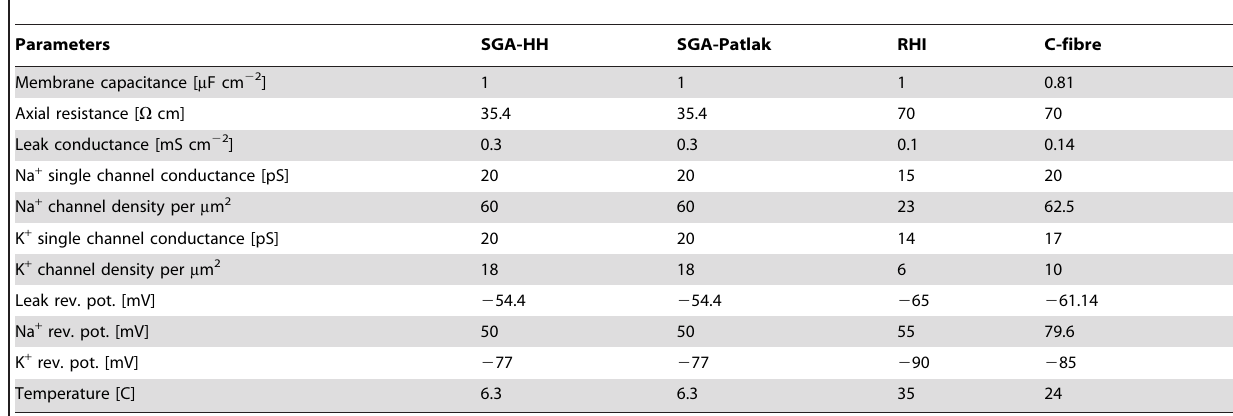
Table 2. Simulation parameters. SGA stands for squid giant axon. RHI stands for rat hippocampal interneuron.